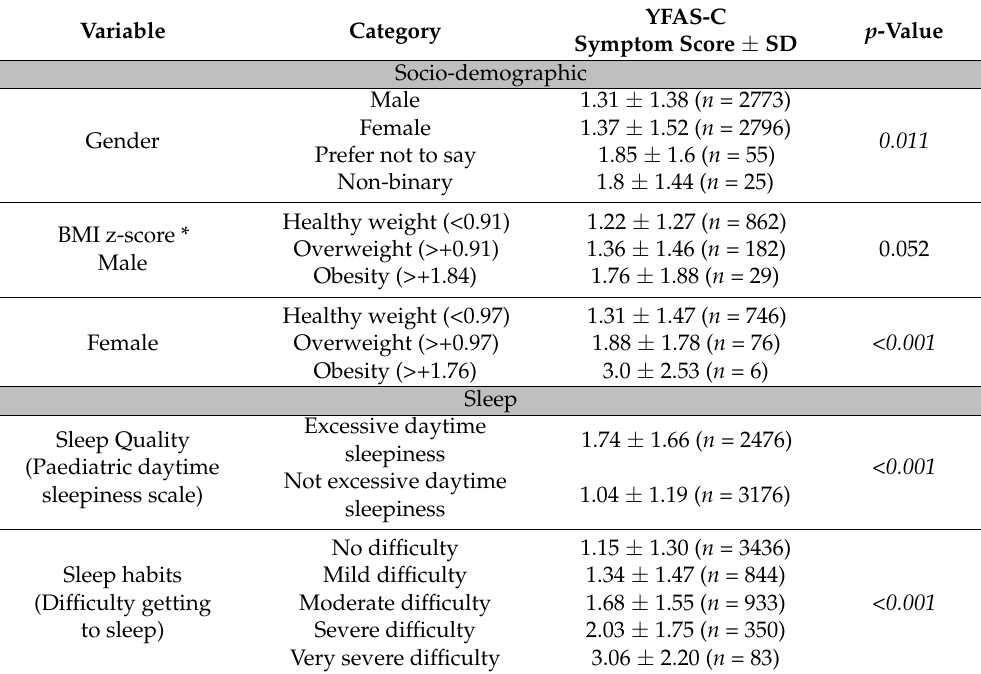
Table 4. Total Food Addiction (YFAS-C) symptom scores by categorical variable for the total sample reported as mean ± S.D and number ( n